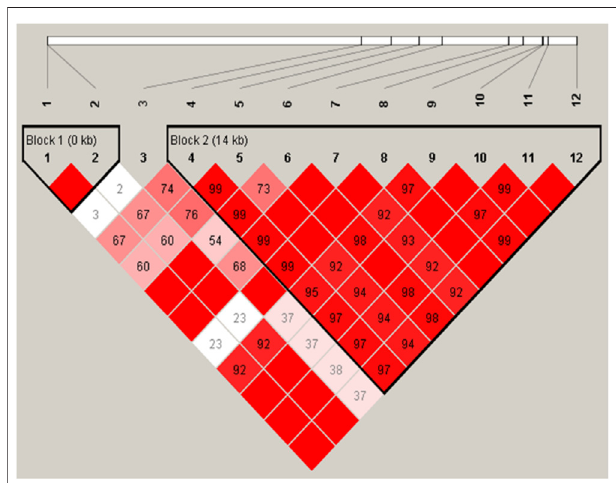
FIGURE 1 | Linkage disequilibrium of the twelve SNPs was detected in the ACSL1 gene in buffalo. The red squares represent high pairwise linkage